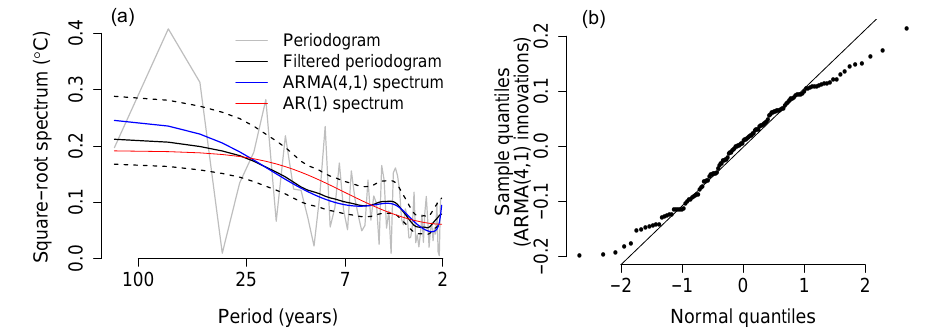
Figure 3. (a) The raw periodogram of the residuals from model (4), a filtered periodogram (twice applying a moving average of width 5), and the power spectra associated with fitted ARMA(4,1) and AR(1) models. The dashed lines are at ± 2 standard errors associated with the filtered periodogram. The ARMA(4,1) model appears to more realistically represent low-frequency variation in the residuals, which is crucial for inferences about trends. (b) Normal quantile–quantile plot for the ARMA(4,1) sample innovations. There is some evidence that the innovations are light-tailed compared to the normal distribution.